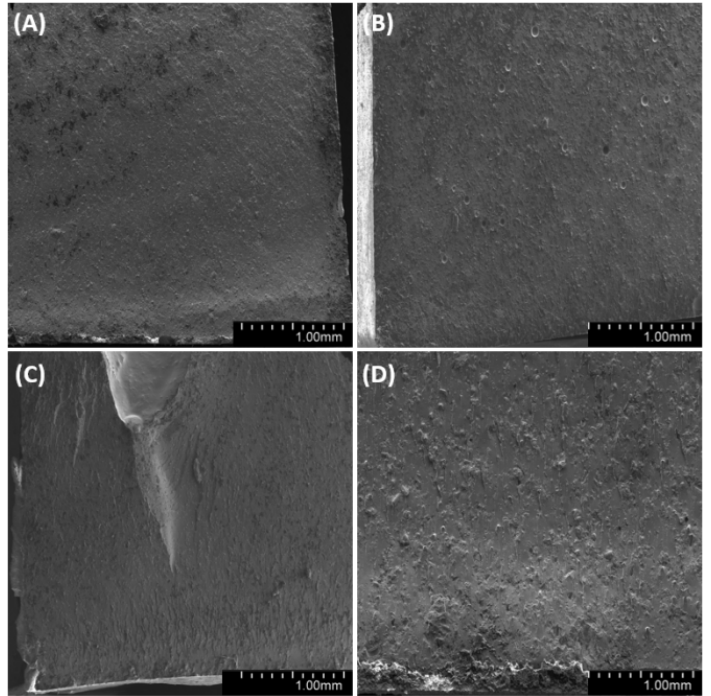
Figure 22. SEM images of the fractures of samples with 36% vol. of diatoms: ( A )—base deg, ( B )—base no deg, ( C )—fractionated deg, ( D )—fractionated no deg.